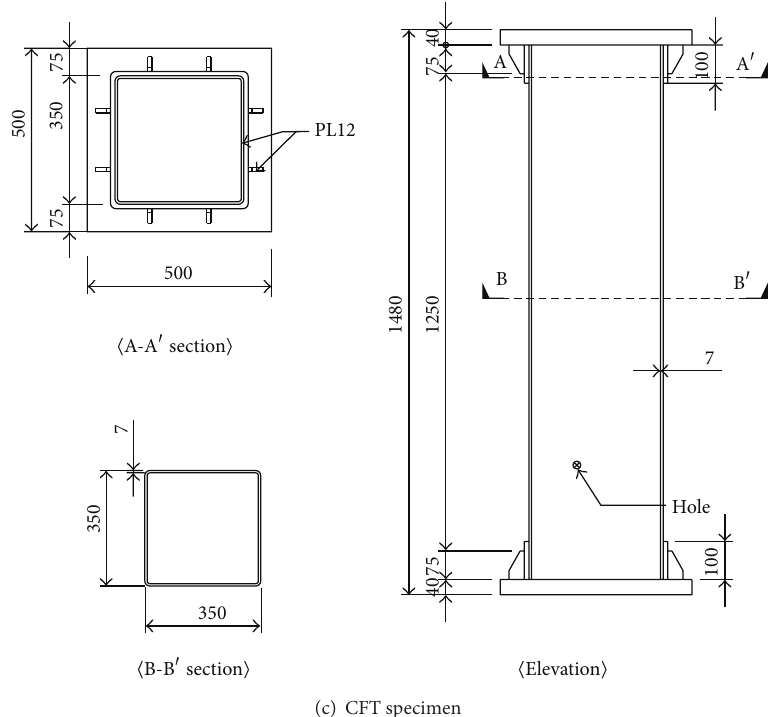
Figure 2: Dimensional details of test specimens.